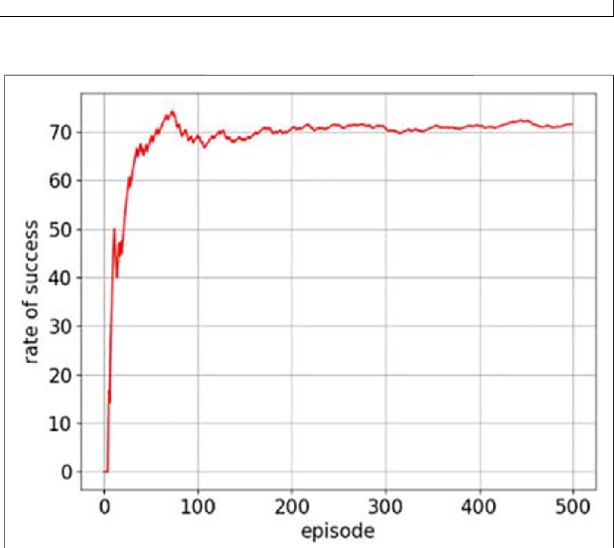
FIGURE 6 | Comparison of the trajectory of the soft arm before and after training.